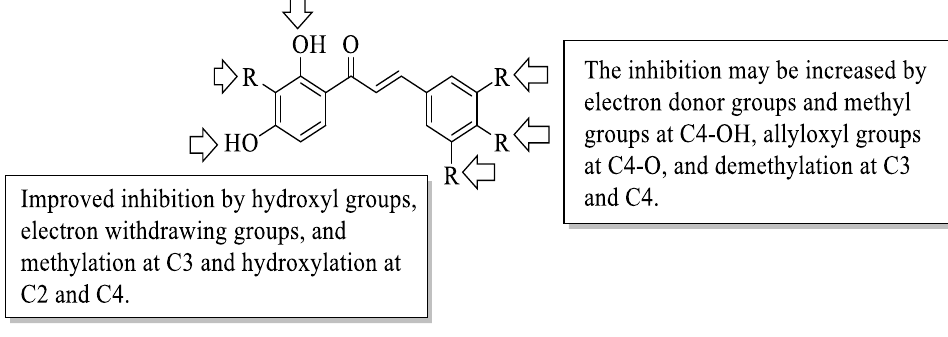
Figure 22. SARs of chalcones for PTP1B inhibition activity [59].